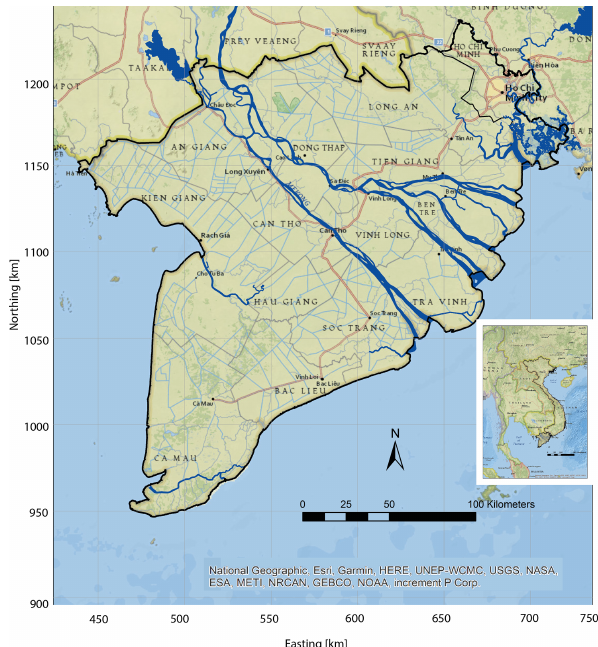
Figure 1. The study area (referred to as the Mekong Delta (MKD) in this paper) includes the Mekong Delta itself as well as a part of the Saigon River delta in the northeast around Ho Chi Minh City; coordinate system WGS84-UTM 48N. The smaller map indicates the Mekong Delta (shaded area) as part of